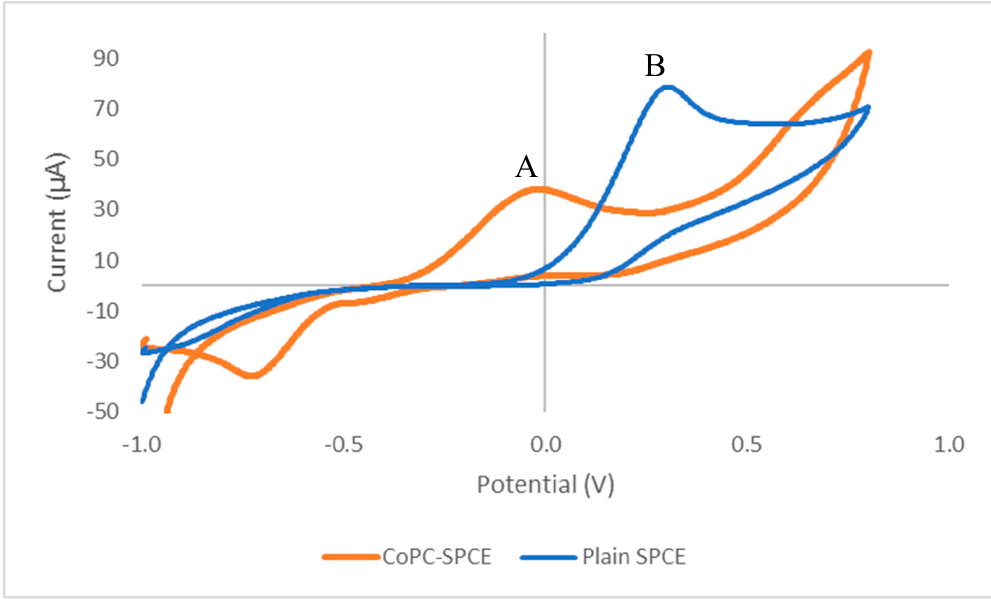
Figure 1. Cyclic voltammetric responses of a screen-printed carbon electrode containing the electrocatalyst cobalt phthalocyanine (CoPC-SPCE) sensor ( A ) and a plain SPCE ( B ) to 10 mM of vitamin B1 at pH 12, and at a scan rate of 50 mV/s.